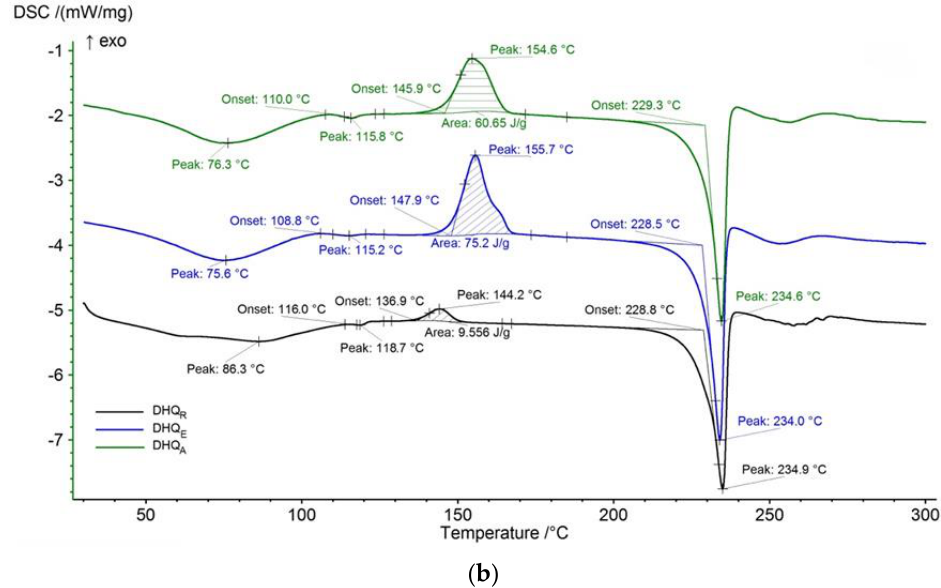
Figure 6. Thermoanalytical curves of different DHQ forms: ( a ) TG; ( b ) DSC. The lyophilized samples were obtained from ethanol and acetonitrile solutions with 5% concertation of organic solvent.